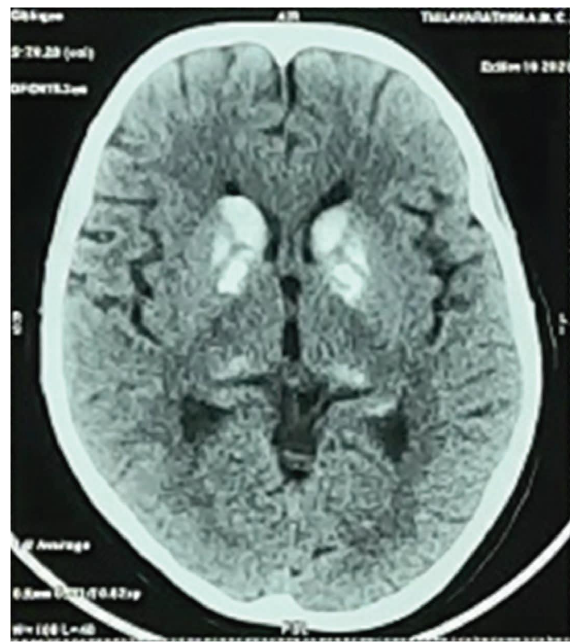
Figure 6: NCCT brain showing basal ganglia